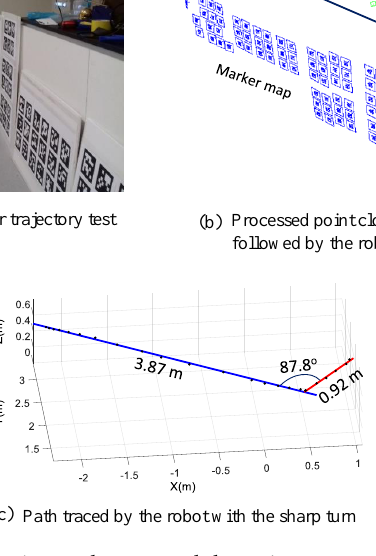
Figure 16. Experimental setup and the trajectory traced by the